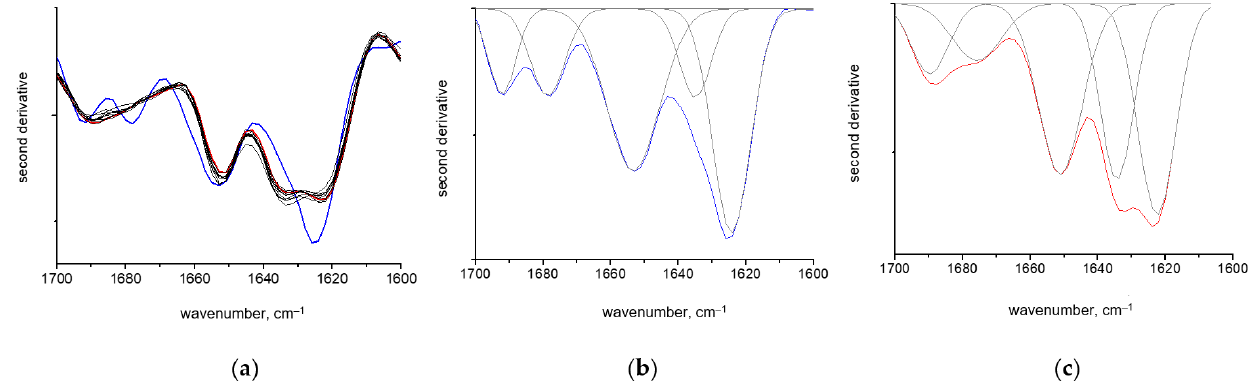
Figure 3. Second derivative spectra of GAPDH solution (blue) and GAPDH– κ -carrageenan mixtures at different mass ratios of 0.1, 0.2, 0.3, 0.4, 0.5, 0.6, 0.7, 0.8, 0.9 and 1.0 in Amide 1 region ( a ). Fitting of second derivative spectra of GAPDH solution ( b ) and the mixture at the ratio 0.2 ( c ) with Gaussian peaks in Amide 1 region.